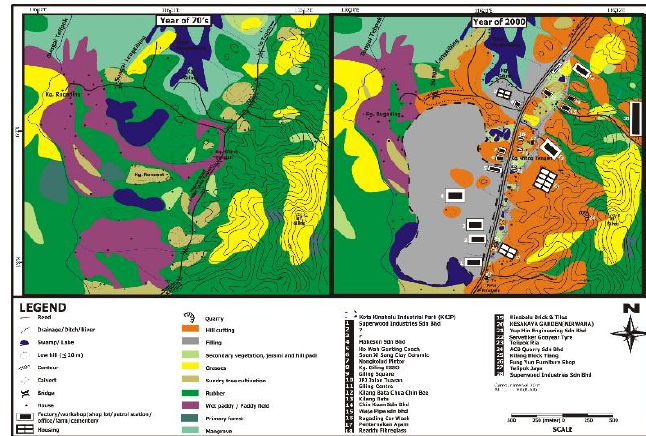
Figure 3: Land use map before (year of 70’s) and after (year o f 2000) urbanization in the study